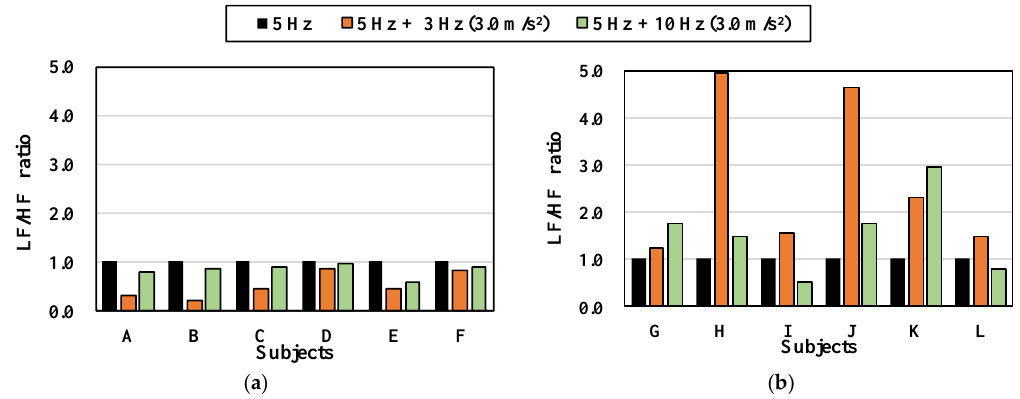
Figure 13. Comparison of subjects by LF/HF values on masking of vibration: ( a ) Subjects of becoming relaxed by masking; ( b ) subjects of becoming stressed by masking.